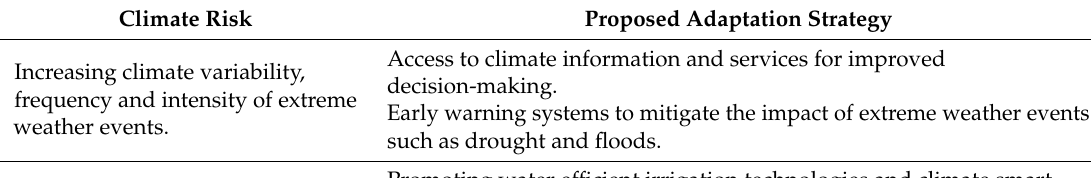
Table 2. Climate change risks on agriculture and adaptation